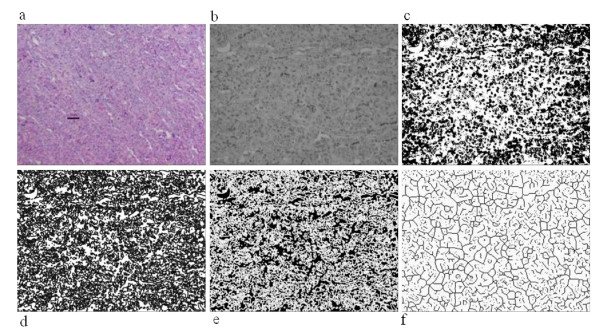
Steps involved in image processing of histological sections of placentome using ImageJ 1.42 q. a. histological image of placental vascular network (Bar = 50 μm; 100× magnification); b. 8 bit image; c. Image smoothened; d. Image with edges; e. Binary conversion; f. Skeletonization.